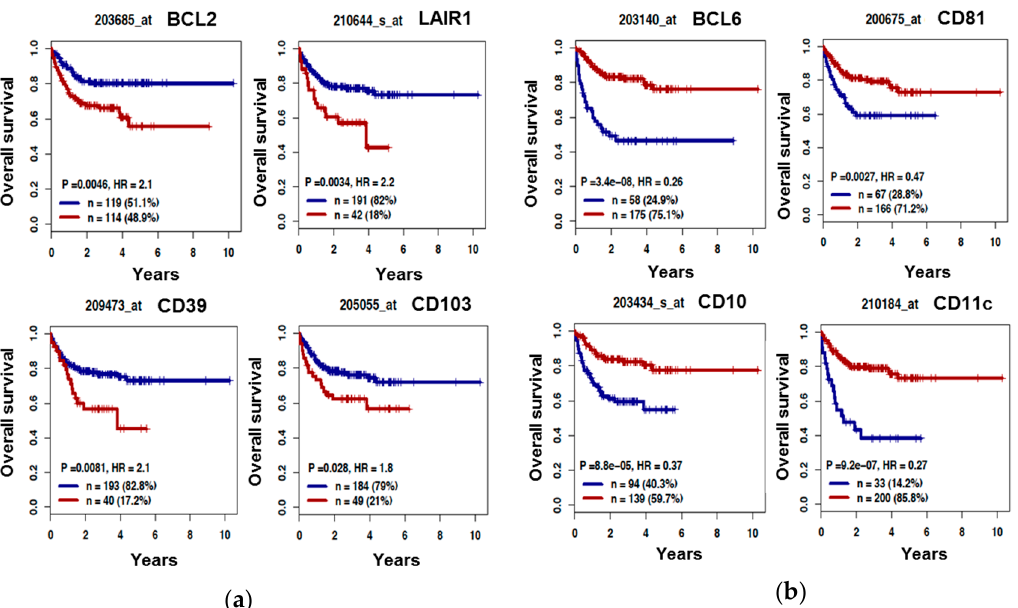
Figure 3. Eight lymphoid markers could predict the outcome of patients with DLBCL. Kaplan-Meier curves indicated that, in the training cohort (R-CHOP Lenz cohort, n = 233), high expression of BCL2 , LAIR1 , CD39 , or CD103 is associated with a poor outcome (i.e., overall survival in function of time) ( a ), whereas high expression of BCL6 , CD81 , CD10 , or Cd11c is associated with better overall survival ( b ). Red, overexpression, and blue, downregulation. Curves were compared with the log rank test. HR: hazard ratio.